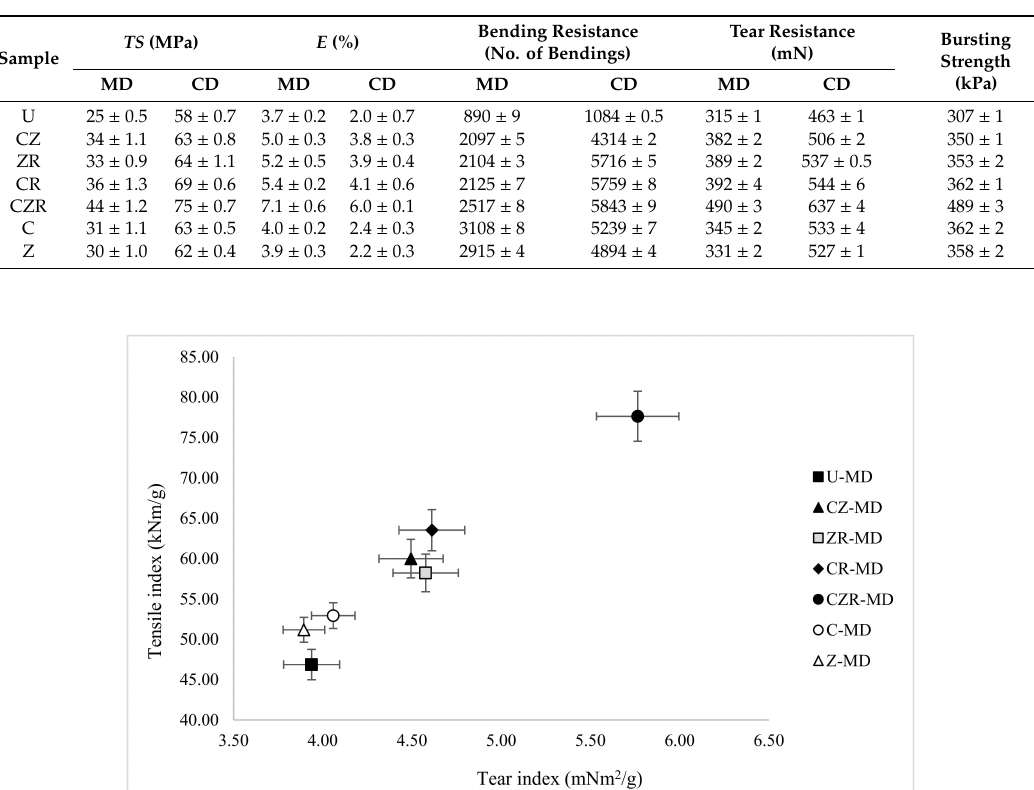
Table 2. Tensile strength ( TS ), elongation ( E ), bursting strength, bending and tear resistance in the cross direction (CD) and machine direction (MD) of the uncoated (U), chitosan and zein coated (CZ), blend zein and rosemary oil coated (ZR), blend chitosan and rosemary oil coated (CR), chitosan, blend zein and rosemary oil coated (CZR), pure chitosan in one layer coated (C) and the pure zein in one layer coated (Z) paper.